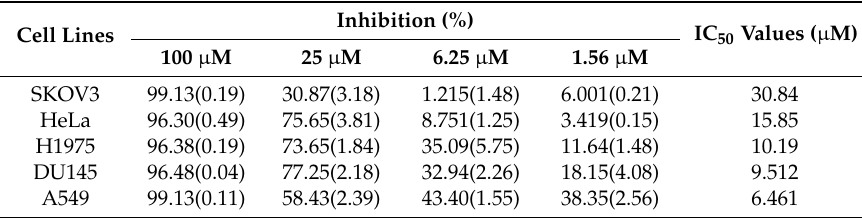
Table 1. Anti-proliferative effects and IC 50 values of salvianolic acid A (Sal A). Cell Lines